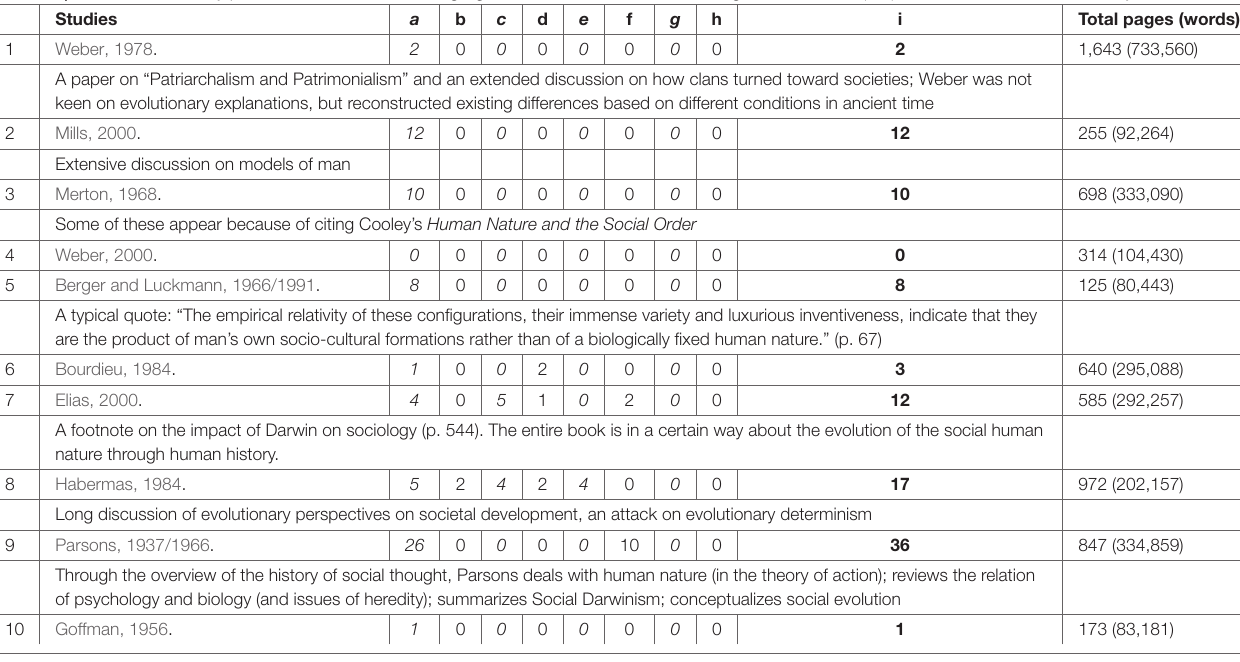
TABLE 4 | Word counts for key phrases and some relevant highlights from the International Sociological Association (ISA) Books of the twentieth Century.